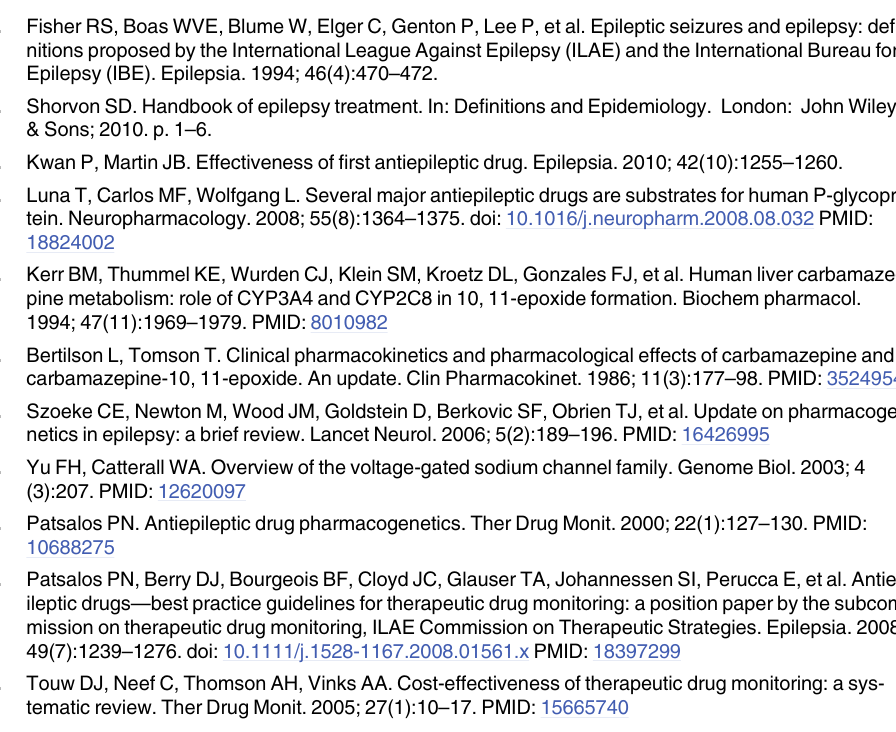
S1 Fig. Correlation between CBZ daily dose and (a) plasma concentration of CBZ and (b) plasma correlation of CBZE. CBZE: carbamazepine-10,11-epoxide. S2 Fig. Graphical representation (boxplot) of the relationship between CBZD:CBZE ratio and EPHX1 SNPs (rs1051740-Tyr113His and rs2234922-His139Arg) diplotypes. P > 0.05 (one way ANOVA). CBZ E: carbamazepine-10,11-epoxide; CBZD: 10,11-dihyroxy-carbamaze- pine. S1 Table. Distribution of SCN1A, ABCB1, EPHX1 genes polymorphisms; genotype and allele frequencies in epileptic patients vs. healthy subjects. S2 Table. CBZ daily dose, CBZ maintenance dose and CBZ plasma level stratified by response to CBZ therapy (responsive vs resistance patients) and corresponding P values for their difference of means (Student ’ s t-test). To match the average CBZ daily doses, n = 43 subjects with the lowest CBZ daily dosages were excluded from the analysis (P > 0.05). Data are mean±standard